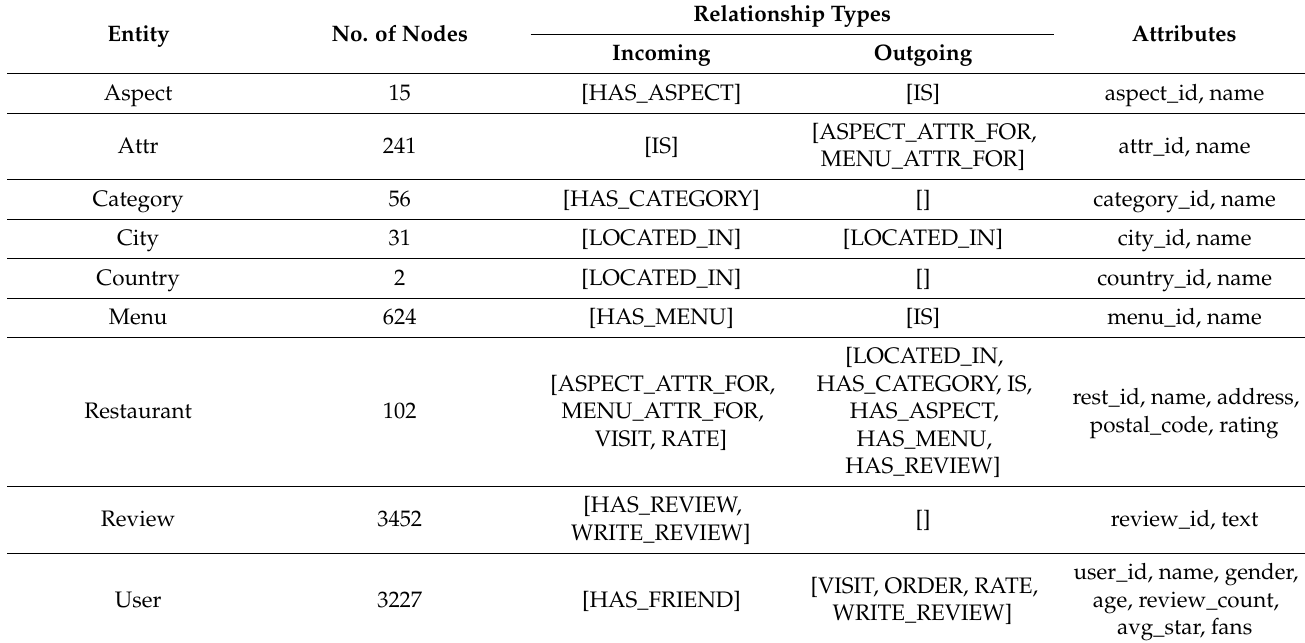
Table 1. Description of domain KG entities and relations.